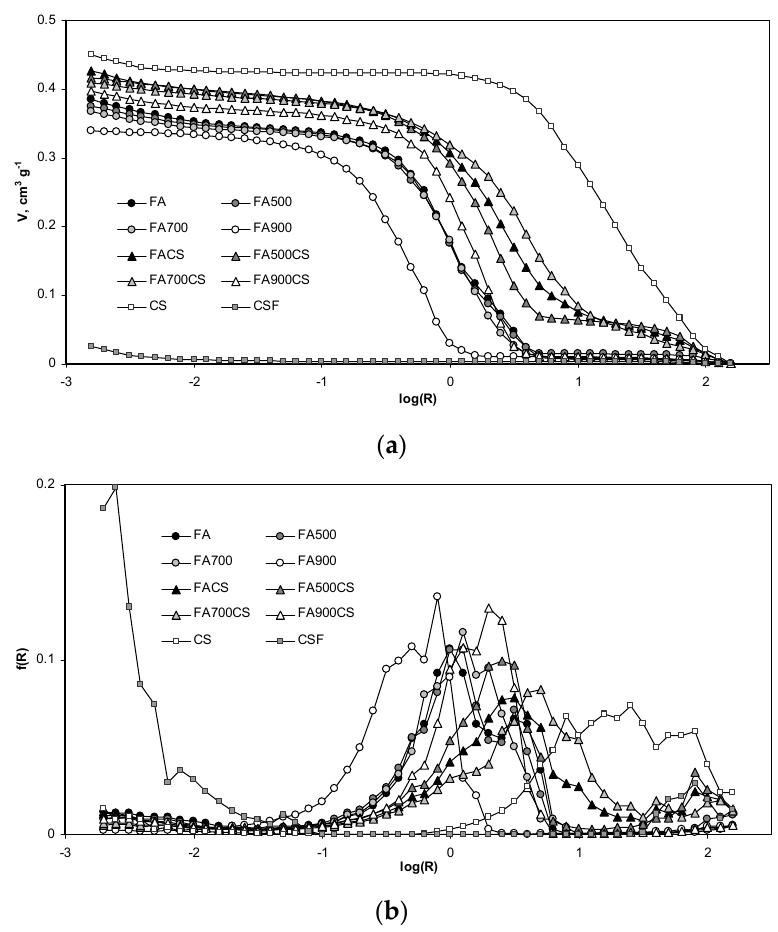
Figure 4. Mercury intrusion curves ( a ) and pore size distribution functions ( b ) for the studied sorbents. Mesopore surface fractal plots for the studied sorbents are illustrated in Figure 5 (only those points belonging to the linear fractality ranges are included).